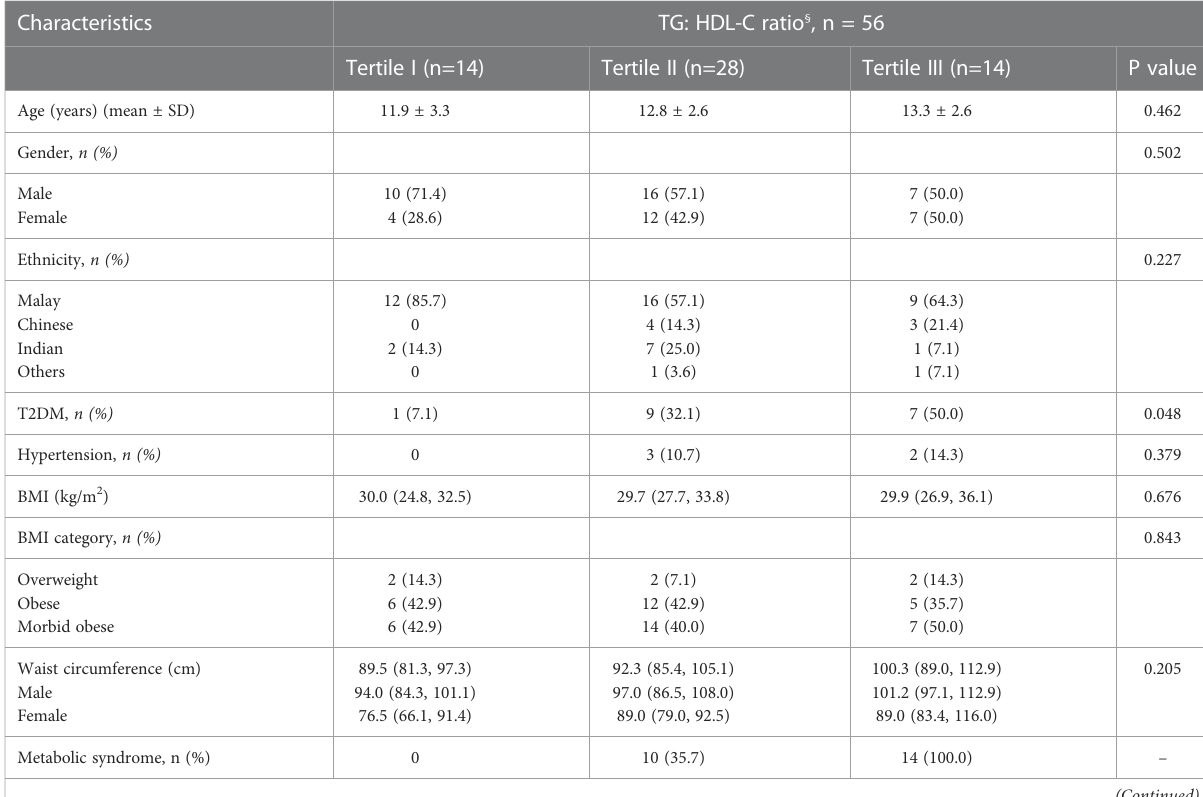
TABLE 1 Comparison of demographic and clinical characteristics of the study population according to tertiles of the TG: HDL-C ratio.